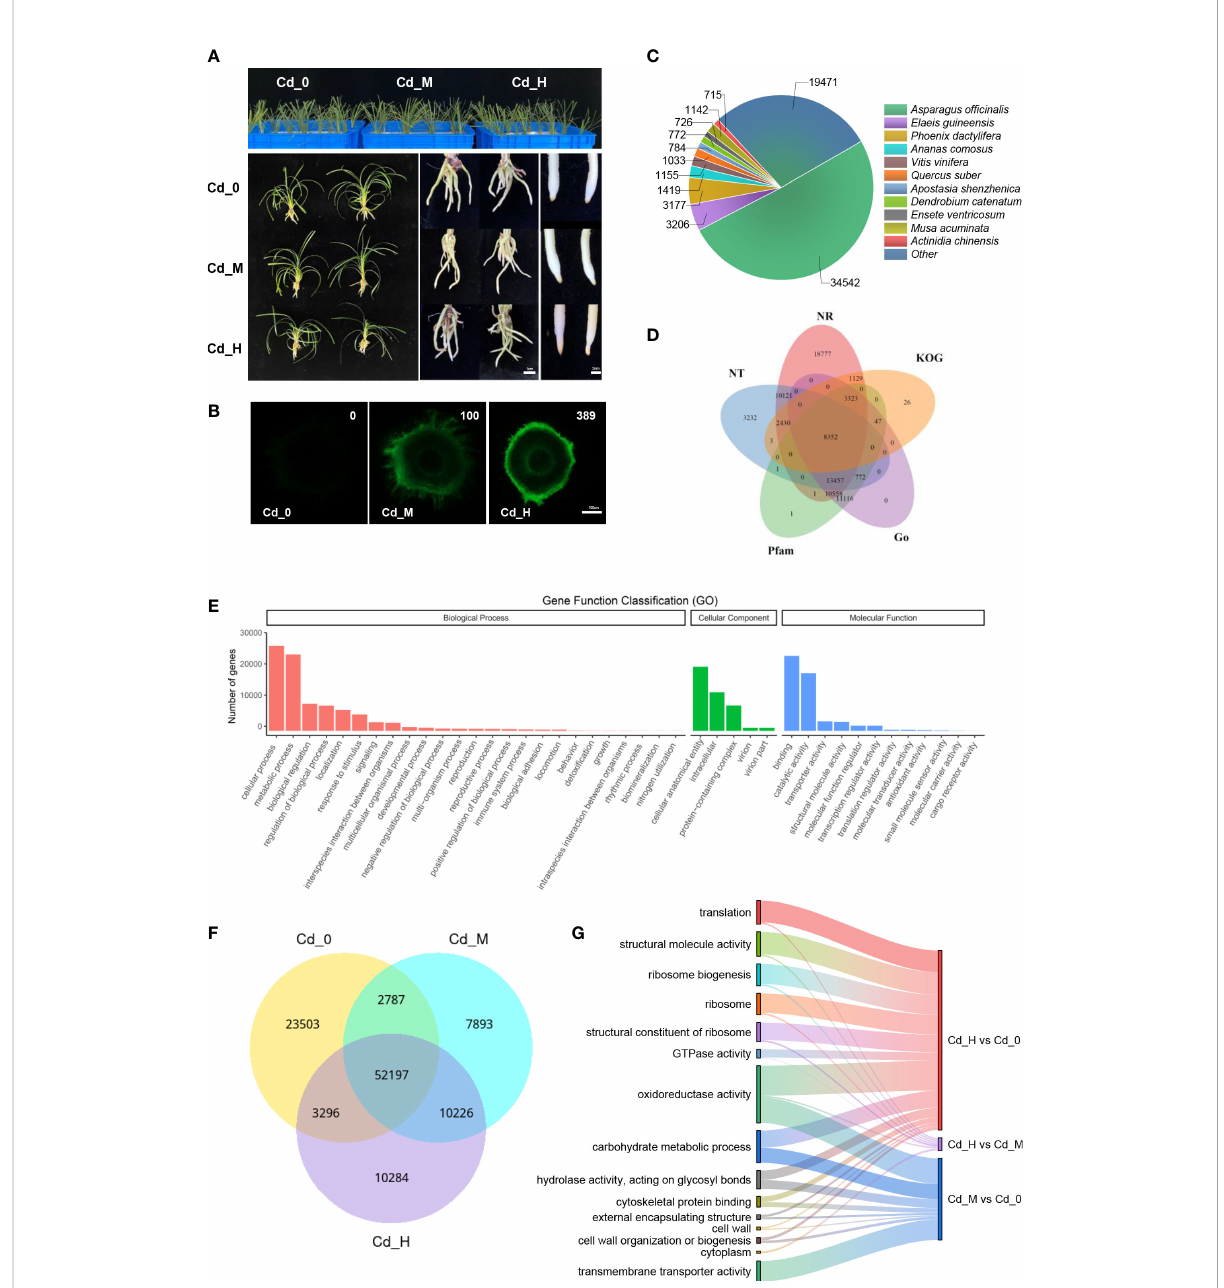
FIGURE 2 The phenotype and DEGs analysis of Zhe-Maidong exposed to three different Cd concertation. (A) The phenotype of Zhe-Maidong exposed to three different Cd concertation by hydroponics. The treatments were control (Cd-0), 1 mg/L Cd (Cd-M), and 10 mg/L Cd (Cd-H). (B) The distribution of Cd 2+ in Zhe-Maidong leaves and roots using Leadmium Green AM dye. For each treatment, images from three technical replicates for three biological repeats were collected. The relative fl uorescence intensities of Cd-0, Cd-M, and Cd-H were 0, 100, and 389, respectively. Bars = 100 µm. (C) Species distribution of homologous proteins of unigenes. The different color blocks represent different species. (D) Distribution of functionally annotated unigenes in the Go, KOG, NR, NT, and Pfam databases. (E) Functional annotation of unigenes based on Gene Ontology (GO) categorization. (F) DEGs under different Cd stress in Zhe-Maidong. (G) Go enrichment analysis of DEGs following the Cd stress treatment. The most signi fi cant 15 terms were chosen to be